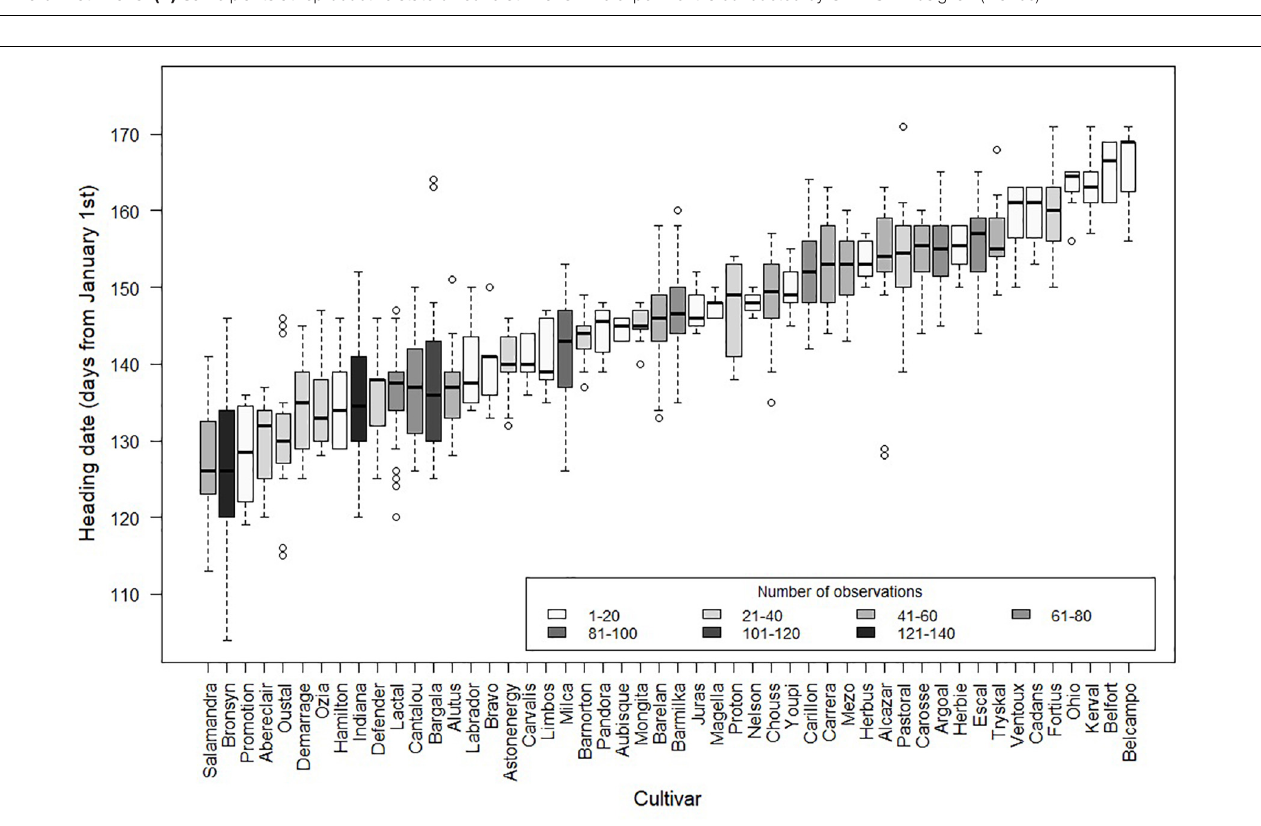
FIGURE 2 | Heading dates of 50 commercial cultivars of Lolium perenne grown for 17 years in seven French locations with contrasted climatic conditions. Heading date is measured as the first date when at least 10 tillers reach heading per linear meter of plants sown during the previous spring. Boxplots represent the variability of heading date between year-location combinations for each cultivar (plot in the style of Tuckey: –1.5*IQR, 2nd quartile, median, 3rd quartile, + 1.5*IQR). The grayscale represents the number of observations per cultivar.